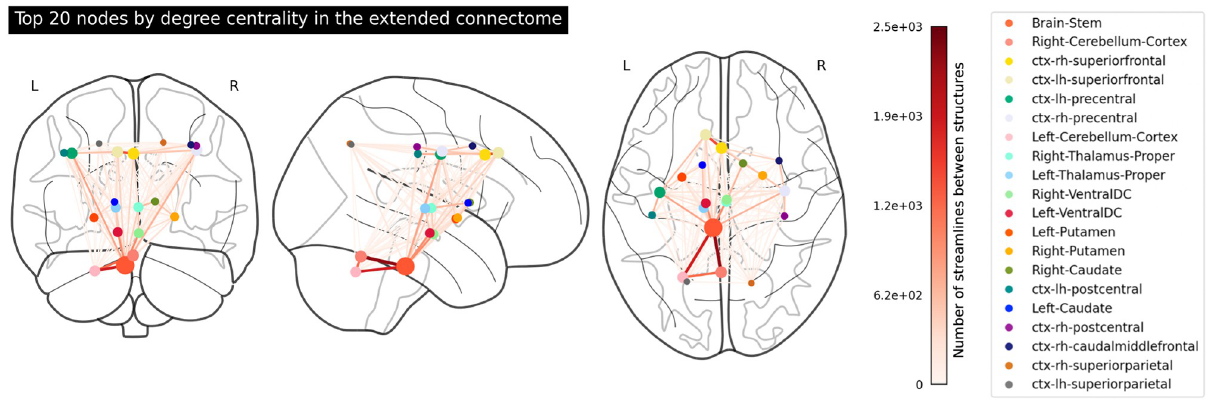
Fig 3. The top 20 most connected structures in the averaged extended connectome by degree centrality. The size of the nodes represents the node density (degree centrality) of the structure, and the edge colours represent the number of streamlines connecting two nodes. The structures are listed in the legend in the order of degree centrality.